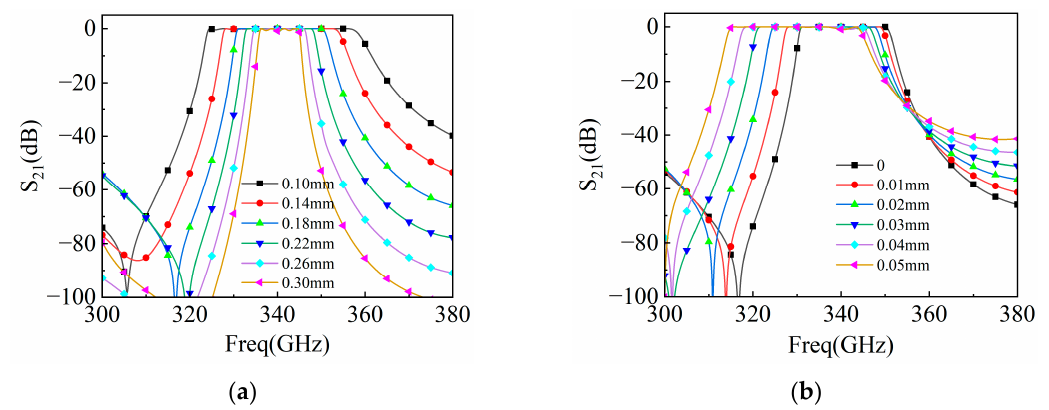
Figure 6. S 21 changes with coupling window parameters. ( a ) Length t of coupling window; ( b ) width w 1 ~ w 4 of coupling window.